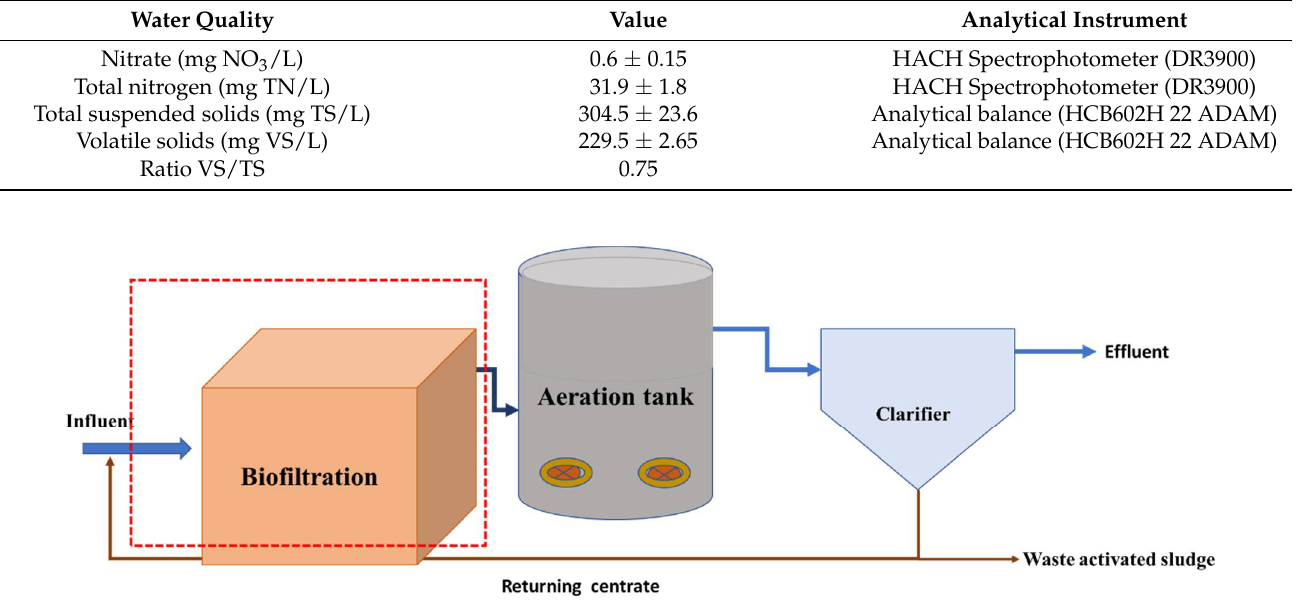
Figure 6. The block diagram of a local South Africa wastewater treatment plant with effluent sampled from the downstream of a biofiltration system Table 5. The characterization of wastewater and activated sludge samples.